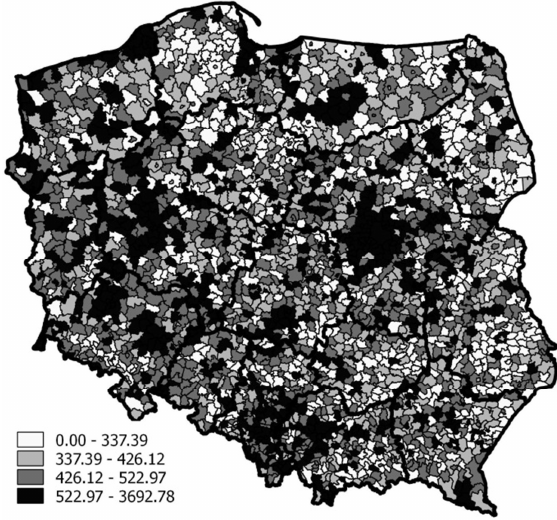
Source: created by the authors based on CSO